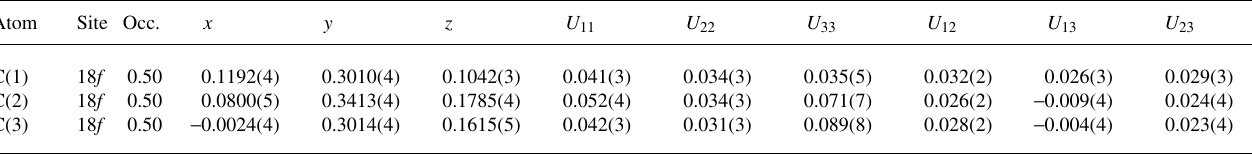
Table 3. Atomic coordinates and displacement parameters (in Å 2 ) . Atom Site Occ.